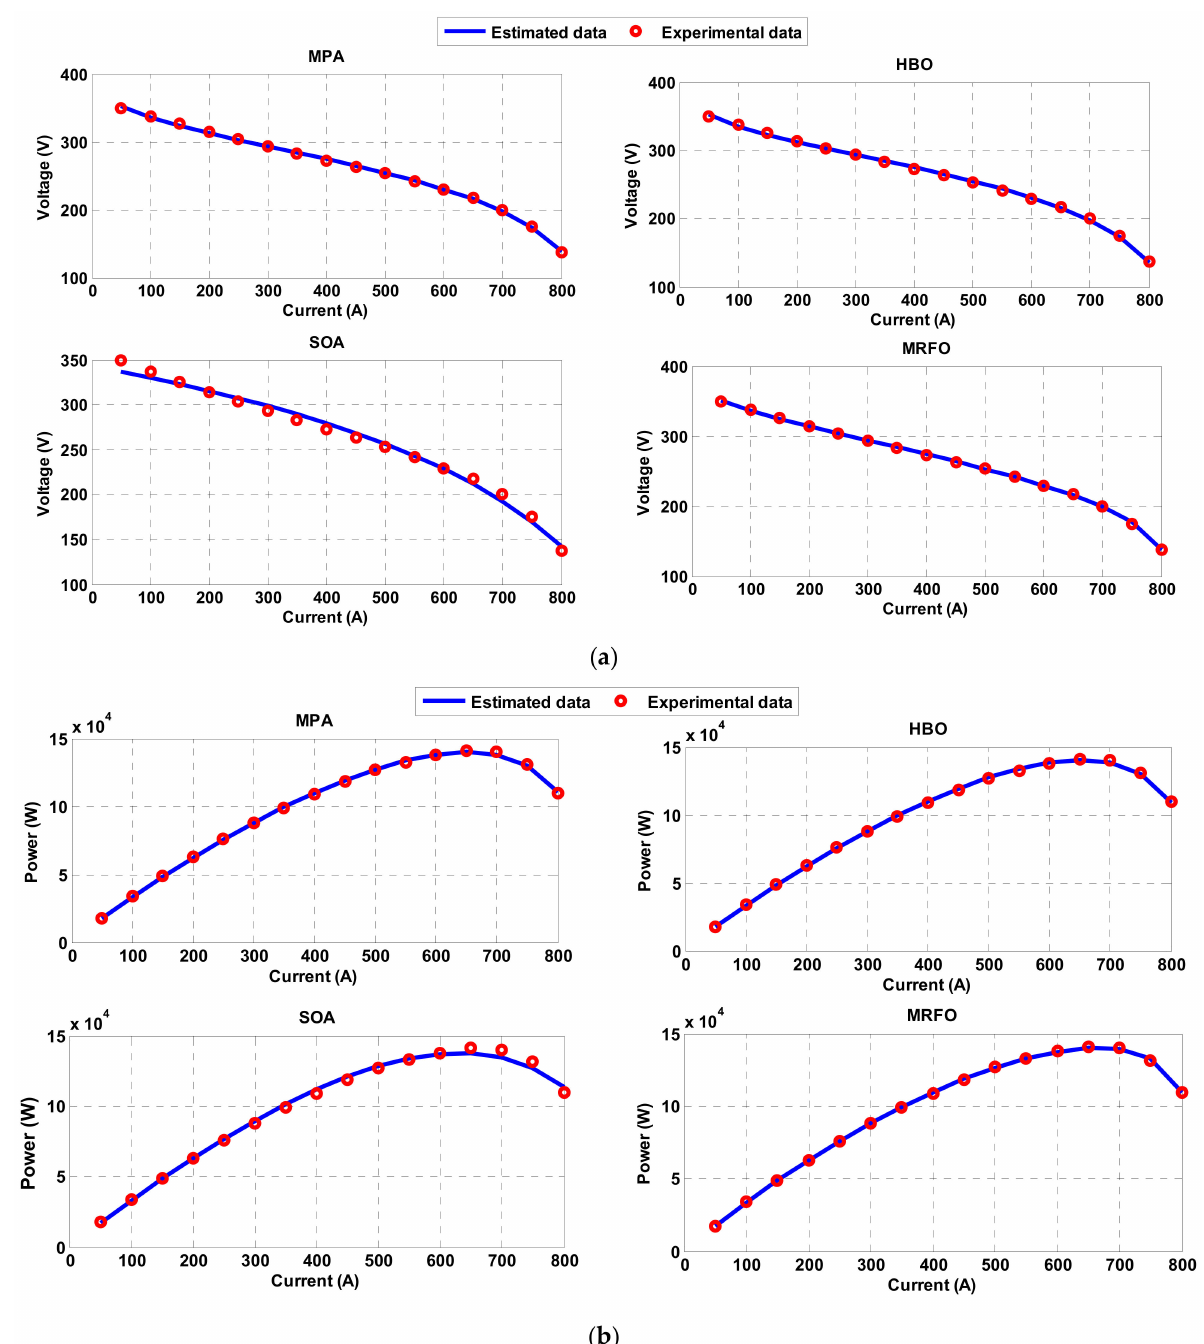
Figure 4. ( a ) Current-voltage curve, ( b ) Current-power curve of SOFC operated at 1073 K obtained via other